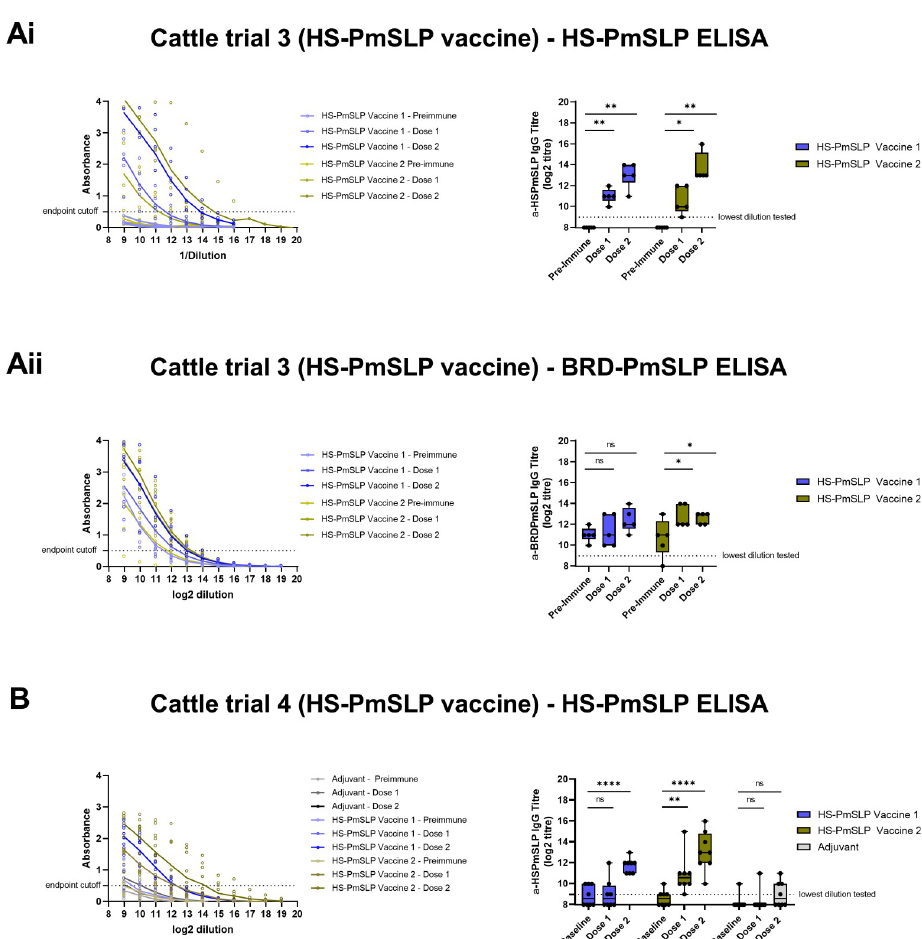
Fig 7. Cattle immunogenicity studies using the HS-PmSLP vaccine. Ai, B: HS-PmSLP antigen specific IgG detected in serum of cattle from Trials 3 and 4 respectively. Aii: Cross-reactivity of serum from Trial 3 against BRD-PmSLP protein. (Left) Background subtracted absorbance readings obtained for each animal using serially diluted serum. Dotted line represents the cut-off used for calculating IgG titre. (Right) Boxplot displaying individual animals. 2-way ANOVA with Dunnett’s multiple comparisons test performed on log2 transformed data to compare post vaccination titres to baseline. * p < 0.05, ** p < 0.01, **** p < 0.0001, ns = not significant. Vaccine 1 formulated with Montanide Gel02 + Poly(I:C), Vaccine 2 formulated with Alhydrogel. Adjuvant controls received Montanide Gel02 + Poly (I:C) only.